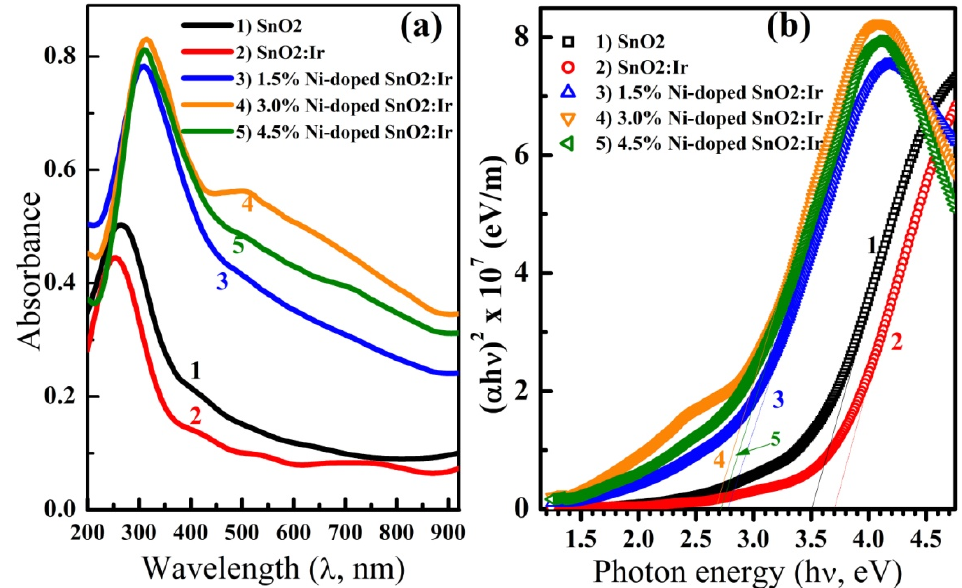
Figure 4. ( a ) UV-vis absorption spectra and ( b ) the bandgap energy determination of SnO 2 , SnO 2 :Ir and 1.5%, 3.0% and 4.5% Ni-doped SnO 2 :Ir.